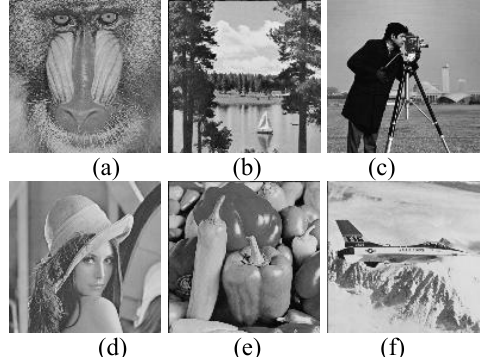
Fig. 6 Process of the feature extraction and matching